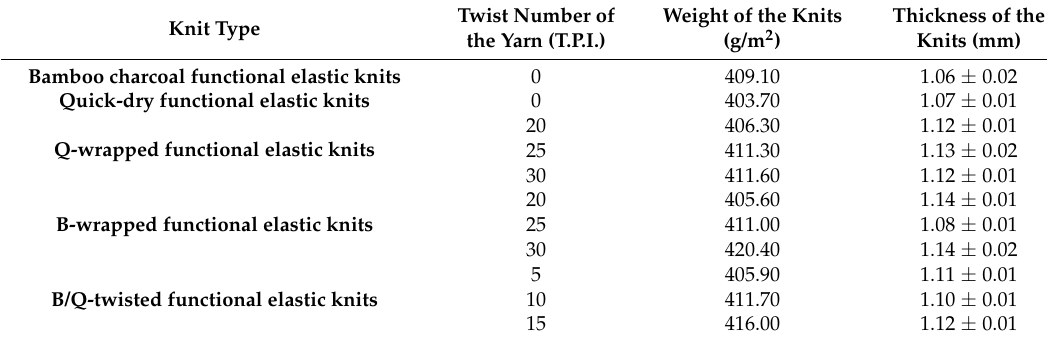
B/Q-twisted functional elastic